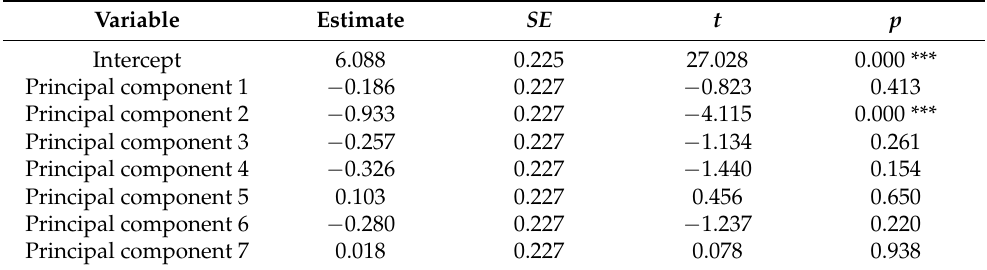
Table 2. GLM results obtained by extracting principal components the all song parameters of